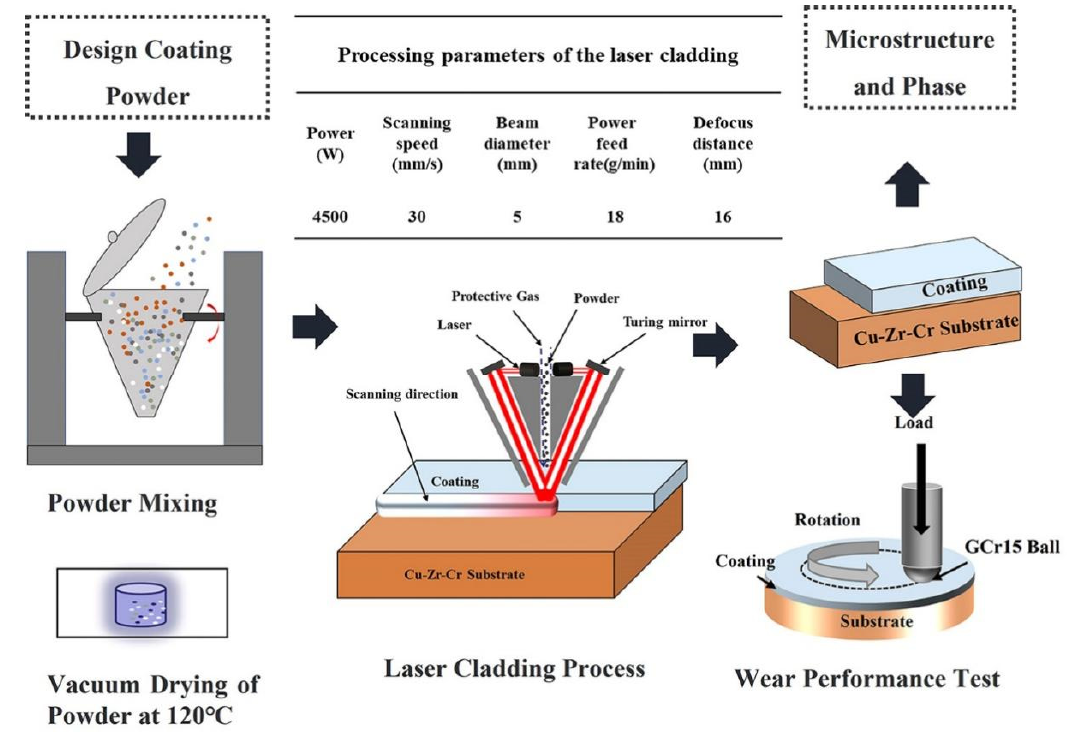
Figure 1. Preparation process, cladding process parameters, and performance test of coatings.